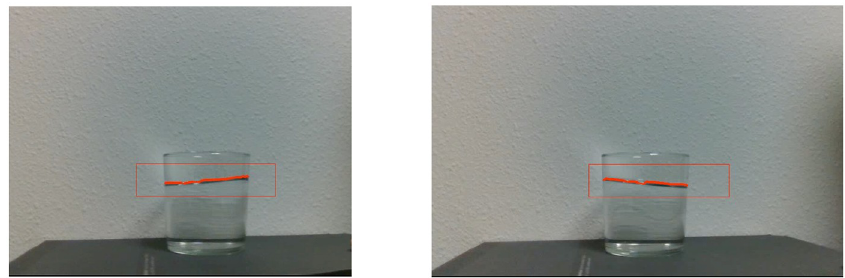
Fig 4. Free surface detection and tracking in video sequence. The points selected to belong to the free surface are highlighted in red over the original frame for